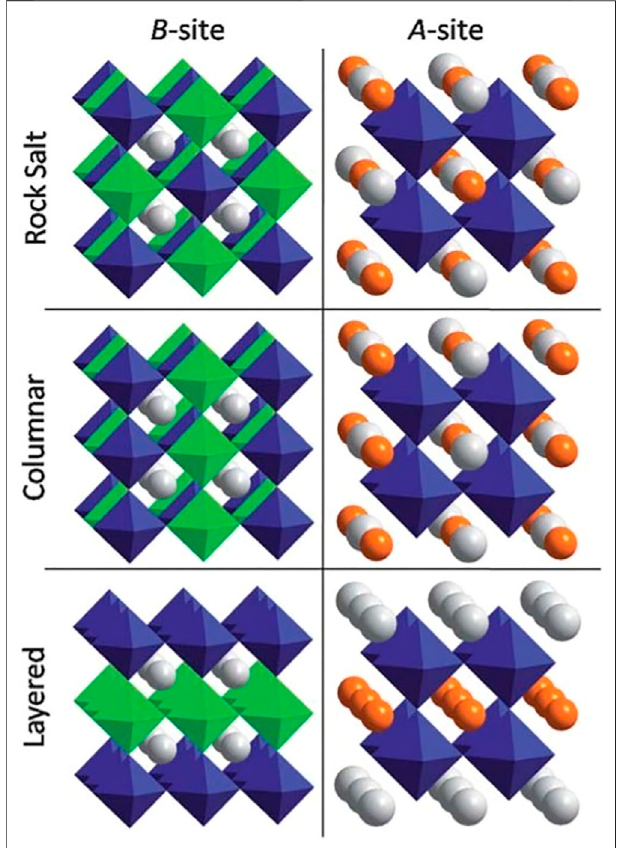
FIGURE 5 | Cation ordering possibilities in perovskites for B-site ordering in A 2 BB ’ X 6 and for A-site ordering in AA ’ B 2 X 6 perovskites. Reproduced with permission from King and Woodward (2010), Copyright Royal Society of